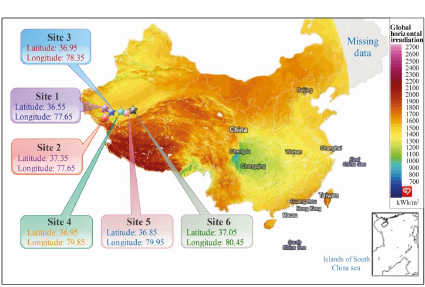
Figure 3: Location description about global solar radiation in the Xinjiang